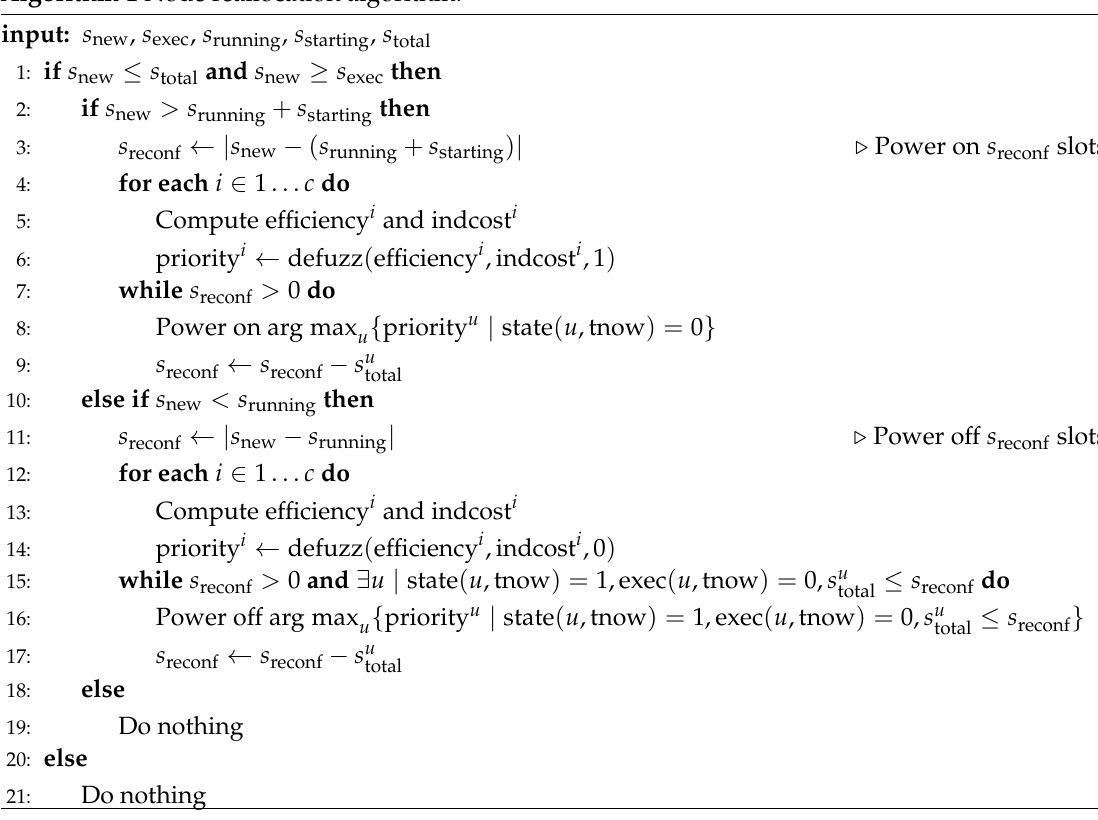
Algorithm 1 Node reallocation